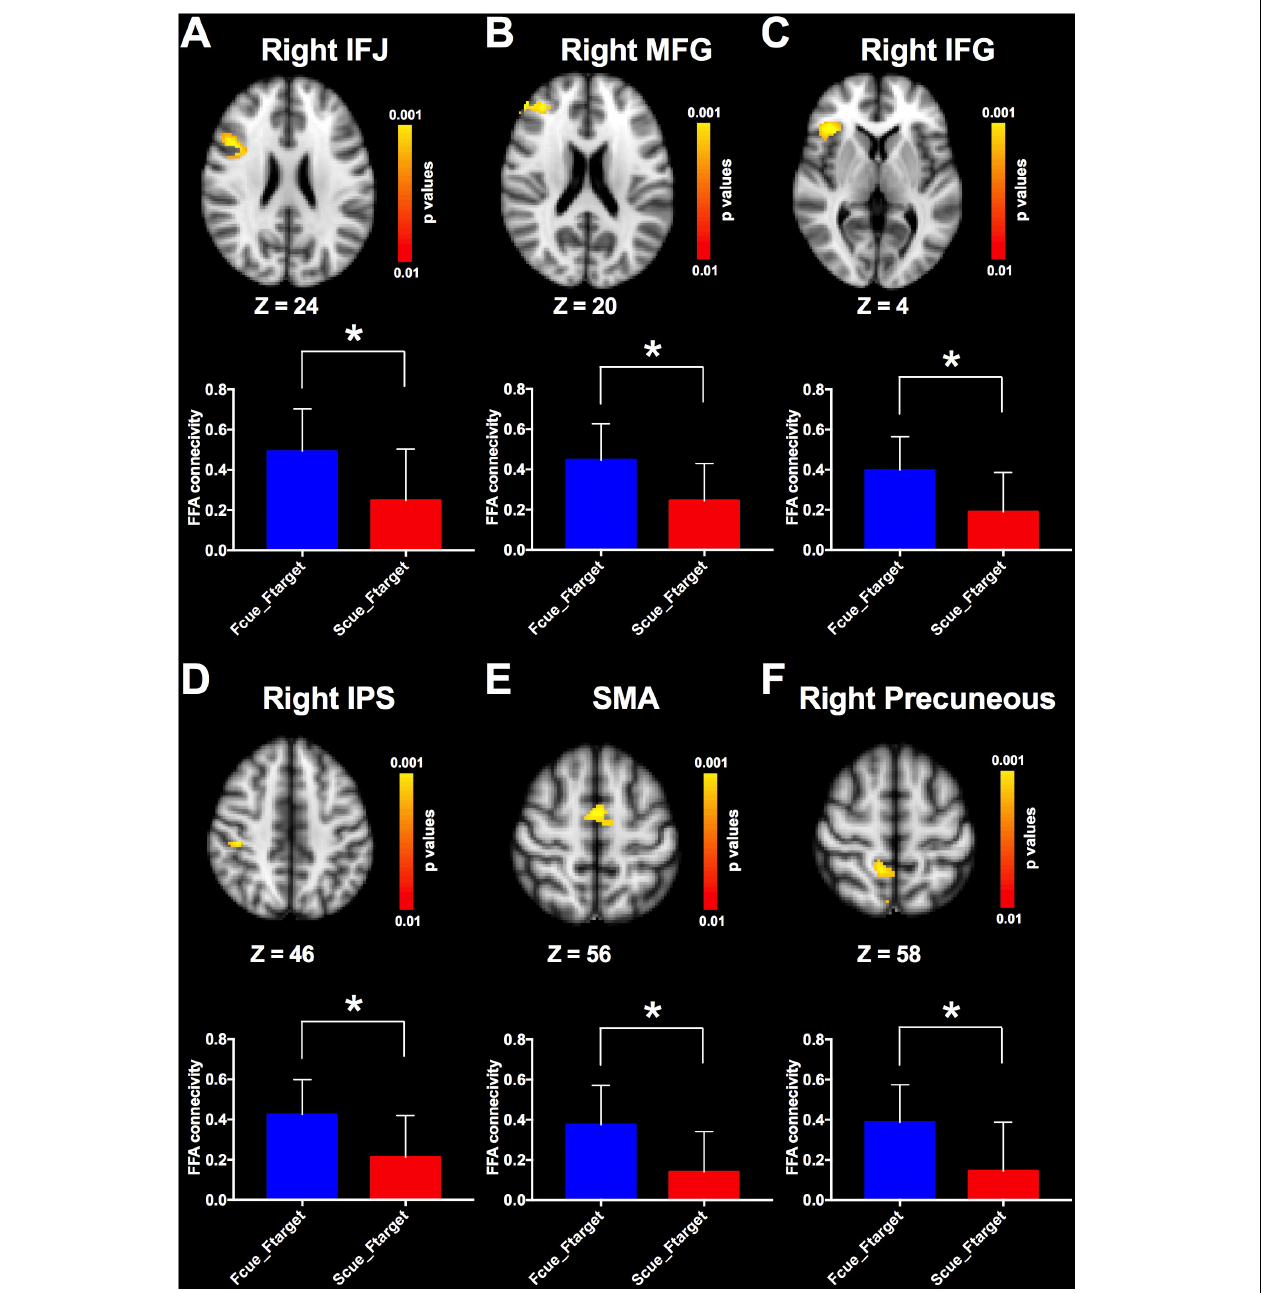
FIGURE 4 | Comparisons of FFA functional connectivity for the contrast of Fcue_Ftarget > Scue_Ftarget. The FFA connectivity with right IFJ (A) , right MFG (B) , right IFG (C) , right IPS (D) , SMA (E) , and right precuneus (F) were significantly increased in Fcue_Ftarget, in contrast to that in Scue_Ftarget. Statistical threshold was set at p < 0.01, FDR corrected at cluster level. Stereotaxic MNI coordinated and mean p -values for significant regions are shown in Table 1 . The symbol ( ∗ ) indicates being significant.